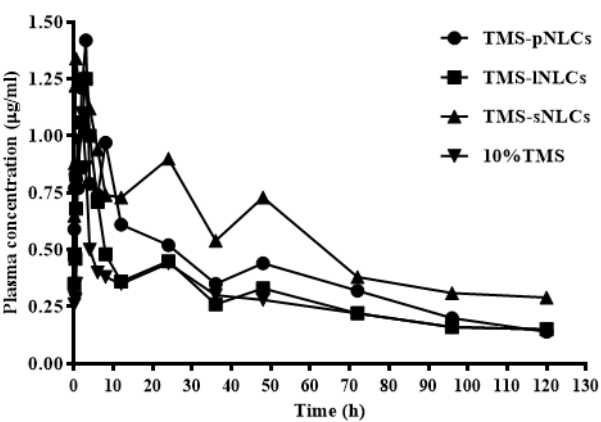
Figure 9. The drug concentration-time curves of TMS after a single oral administration of TMS-NLCs and 10% TMS with 25 mg/kg body weight (B.W.) in broilers ( n = 10). Table 1. Pharmacokinetic parameters of 10%TMS, TMS-pNLCs, TMS-lNLCs, and TMS-sNLCs orally administrated in the broiler chickens (non-compartmental model). C max : maximum concentration;